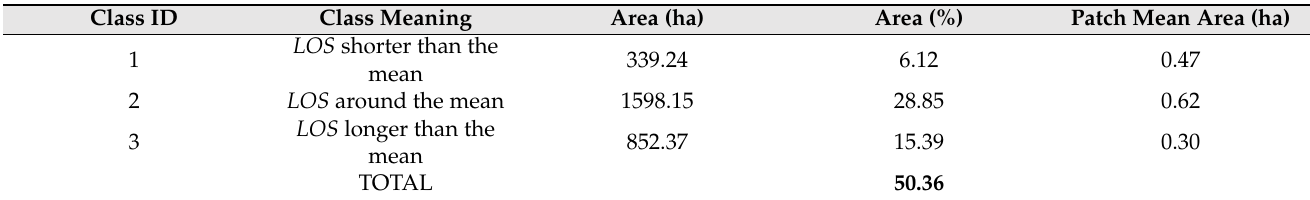
Table 6. Areal metrics about LOS values of vegetated areas in Torino. Area values and percentages refer to those patches showing a stable behavior in terms of LOS anomaly along the three investigated years. These, globally, size the 50.36% of the whole vegetated area of the city (5540.11